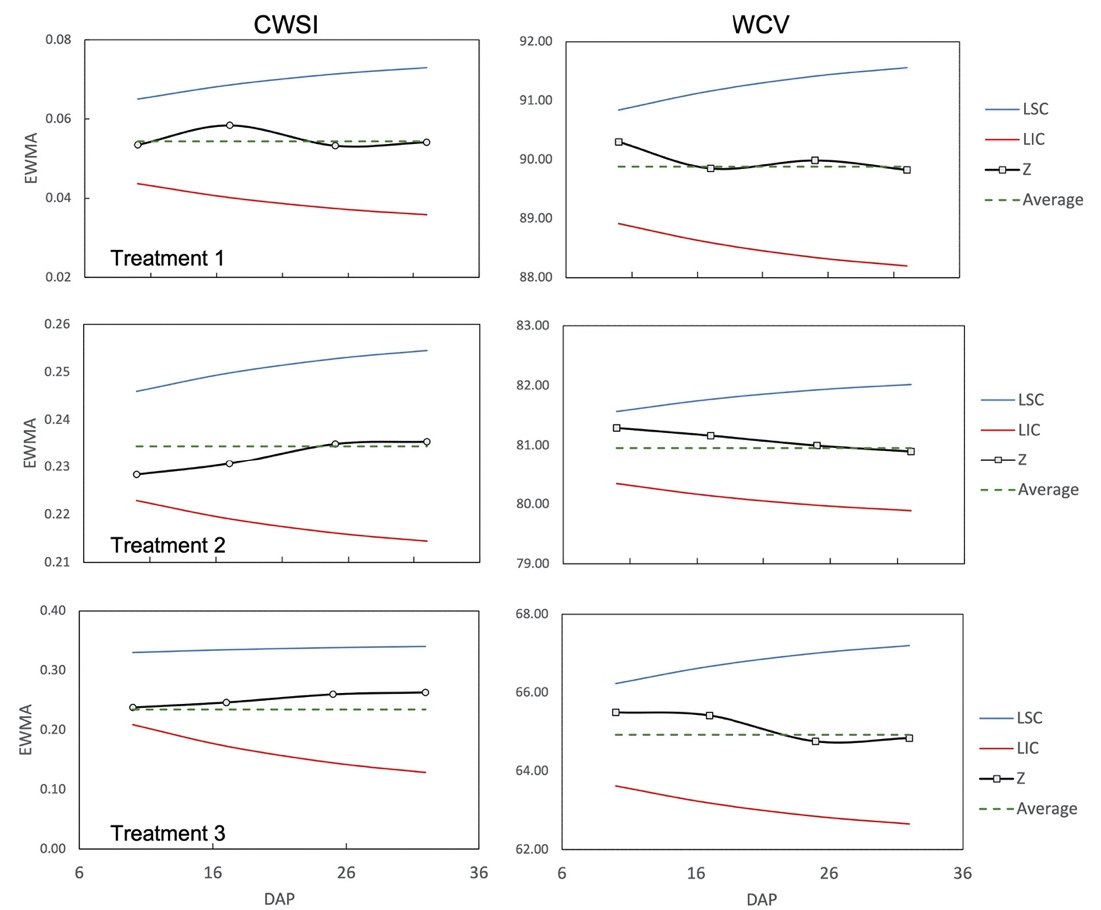
Figure 17. Charts of the exponentially weighted moving average of the CWSI (Crop Water Stress Index) and VWC (Volumetric Water Content) for each treatment. Treatment 1 (T 1 = 85% FC (Field Capacity)); Treatment 2 (T 2 = 75% FC); Treatment 3 (T 3 = 55% FC). LSC (Upper Control Limit), LIC (Lower Control Limit), Z (Exponentially Weighted Moving Average).